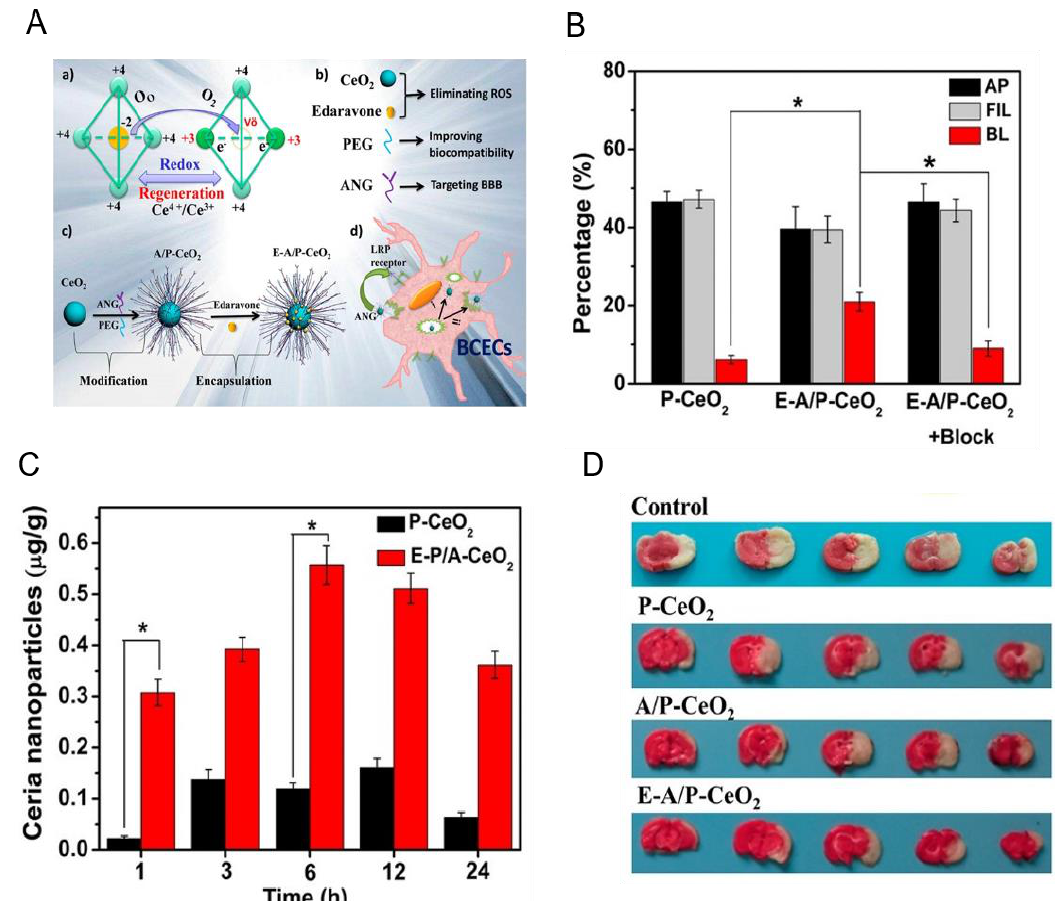
Figure 4. Edaravone-loaded ceria nanoparticles cross the blood brain barrier and protect the brain from ischemic stroke. ( A ) The nanoplatform is comprised of ceria nanoparticle core, PEG shell, and ANG as targeting peptide. ( a ) Transition between cerium(III) and cerium(IV) species in ceria NPs; ( b ) main components of the nanoparticle system; ( c ) synthetic procedure for E-A / P-CeO 2 ; ( d ) receptor-mediated (ANG-LRP) endocytosis of E-A / P-CeO 2 . ( B ) Transmigrated amount of P-CeO 2 and E-A / P-CeO 2 in in vitro transmigration model. Free ANG was used as the blocking agent in group 3. ( C ) Concentrations ( µ g Ce / g brain tissue) of ceria nanoparticles in normal brain tissue. The injection dose was 0.5 mg / kg. ( D ) Representative TTC (triphenyl tetrazolium chloride)-stained brain sections after di ff erent treatments within 24 h of stroke. Data represent mean ± standard deviation (SD). * indicates p < 0.05. Reproduced with permission [63]. Copyright 2018, American Chemical Society.